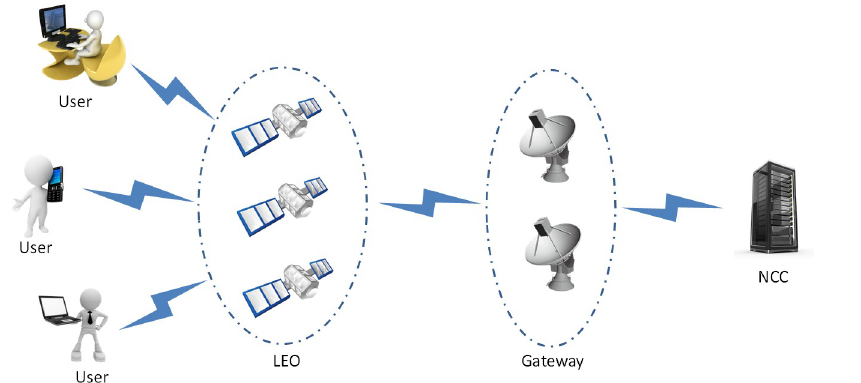
Fig 1. A LEO satellite communication